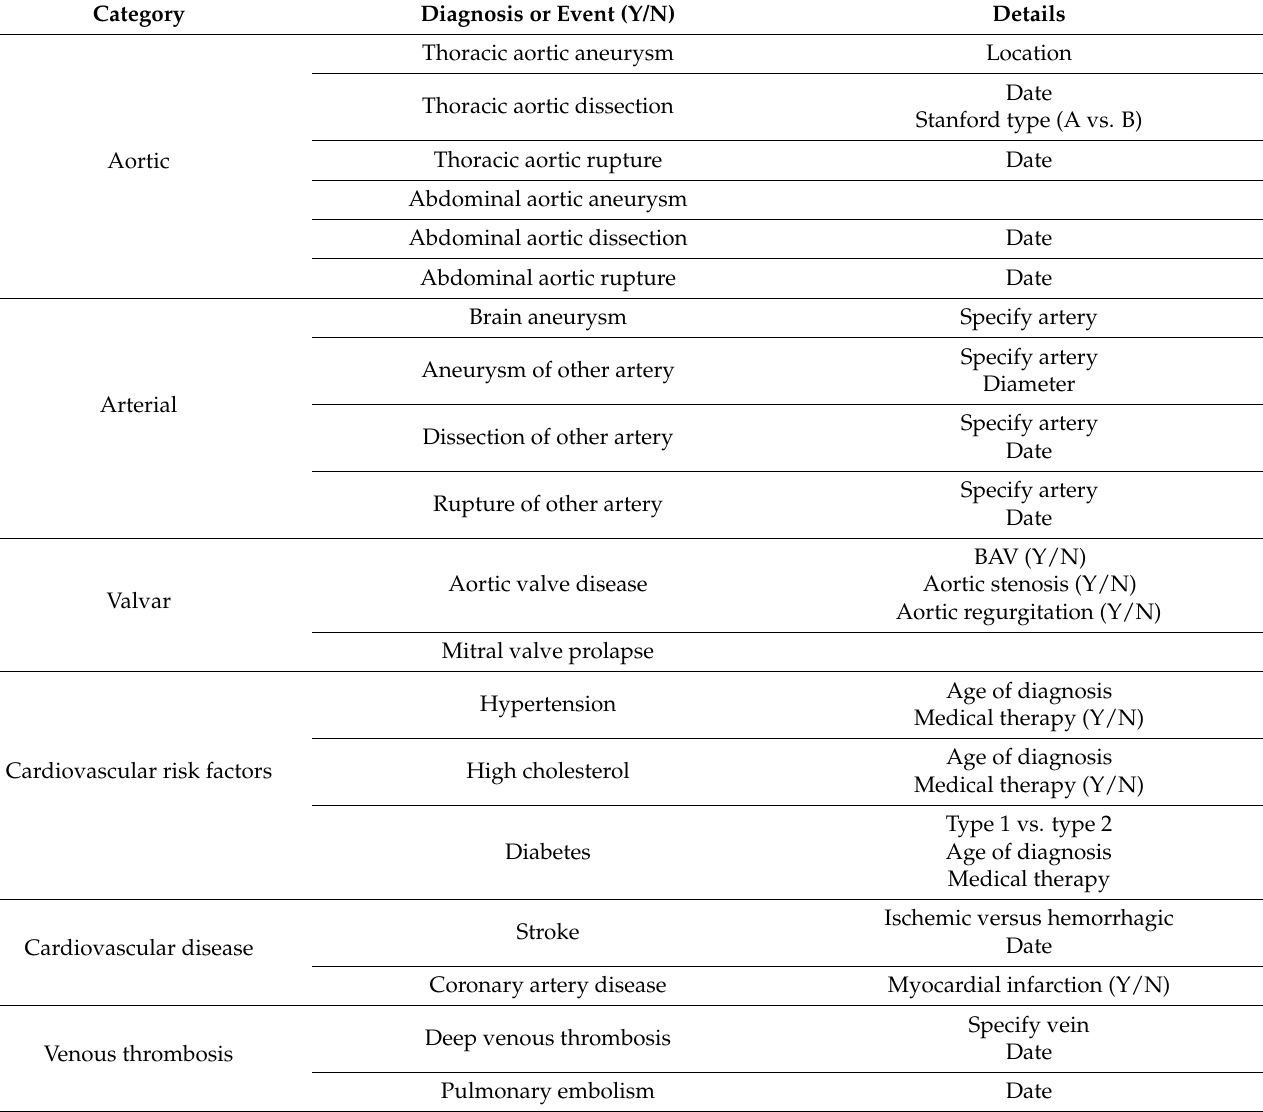
Table 2. Cardiovascular-related data collected through structured interviews and electronic medical record review.